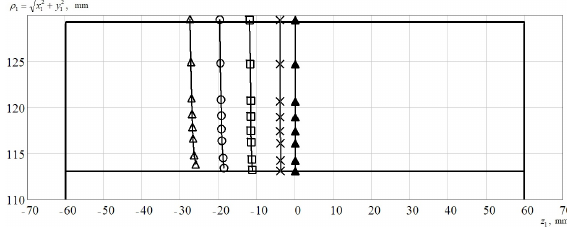
Figure 5. Active lines of action in meshing η =0 ( ▲ ); 1´ ( × ); 3´ ( □ );5´ ( ○ ) and 7´ ( ∆ ) (variant 1) Figure 6 shows active lines of action in meshing with η =0´; 1´; 3´; 5´ and 7´ for variant 2.